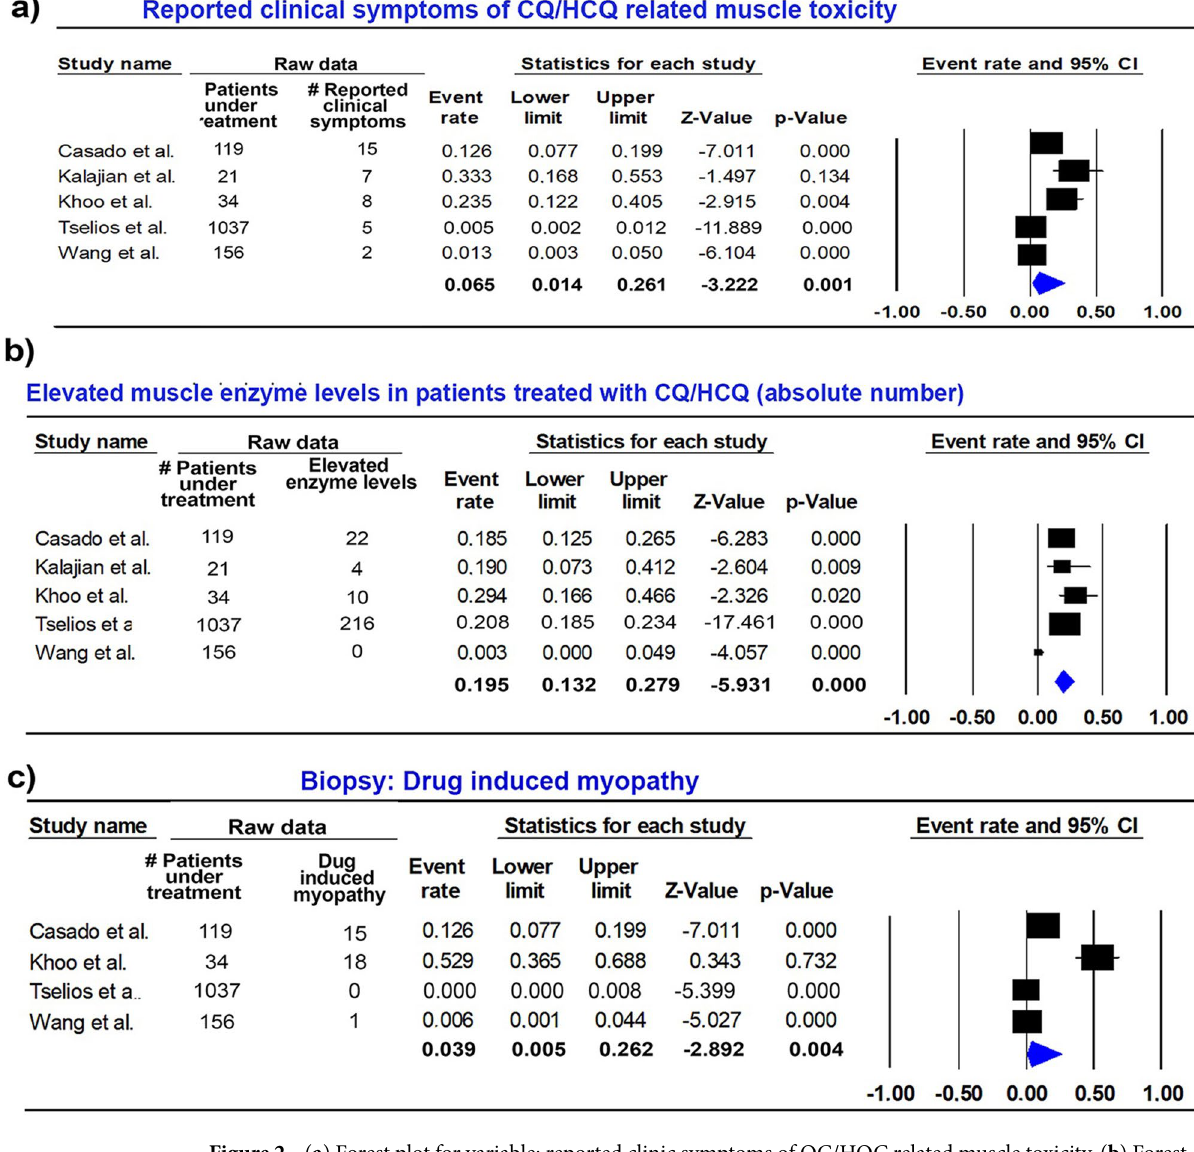
Figure 2. ( a ) Forest plot for variable: reported clinic symptoms of QC/HQC related muscle toxicity. ( b ) Forest plot for variable: Laboratorial findings of elevated muscle enzyme levels in patients treated with QC/HQC. ( c ) Forest plot for variable: Confirmatory Biopsy for Drug-induced myopathy. CI confidence